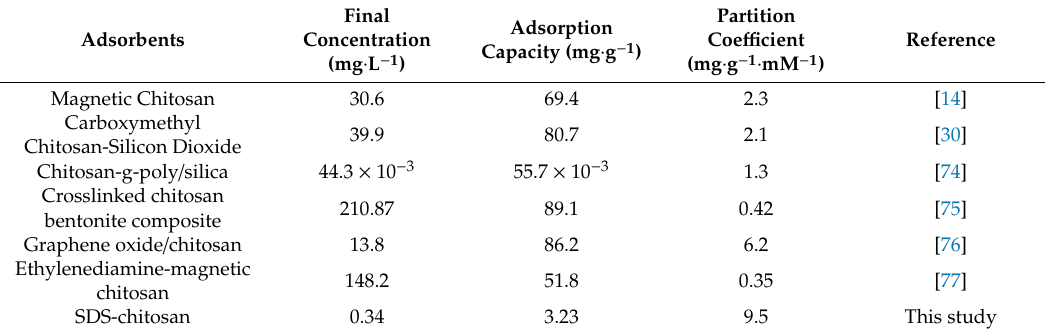
Table 7. The comparison of adsorption properties of several